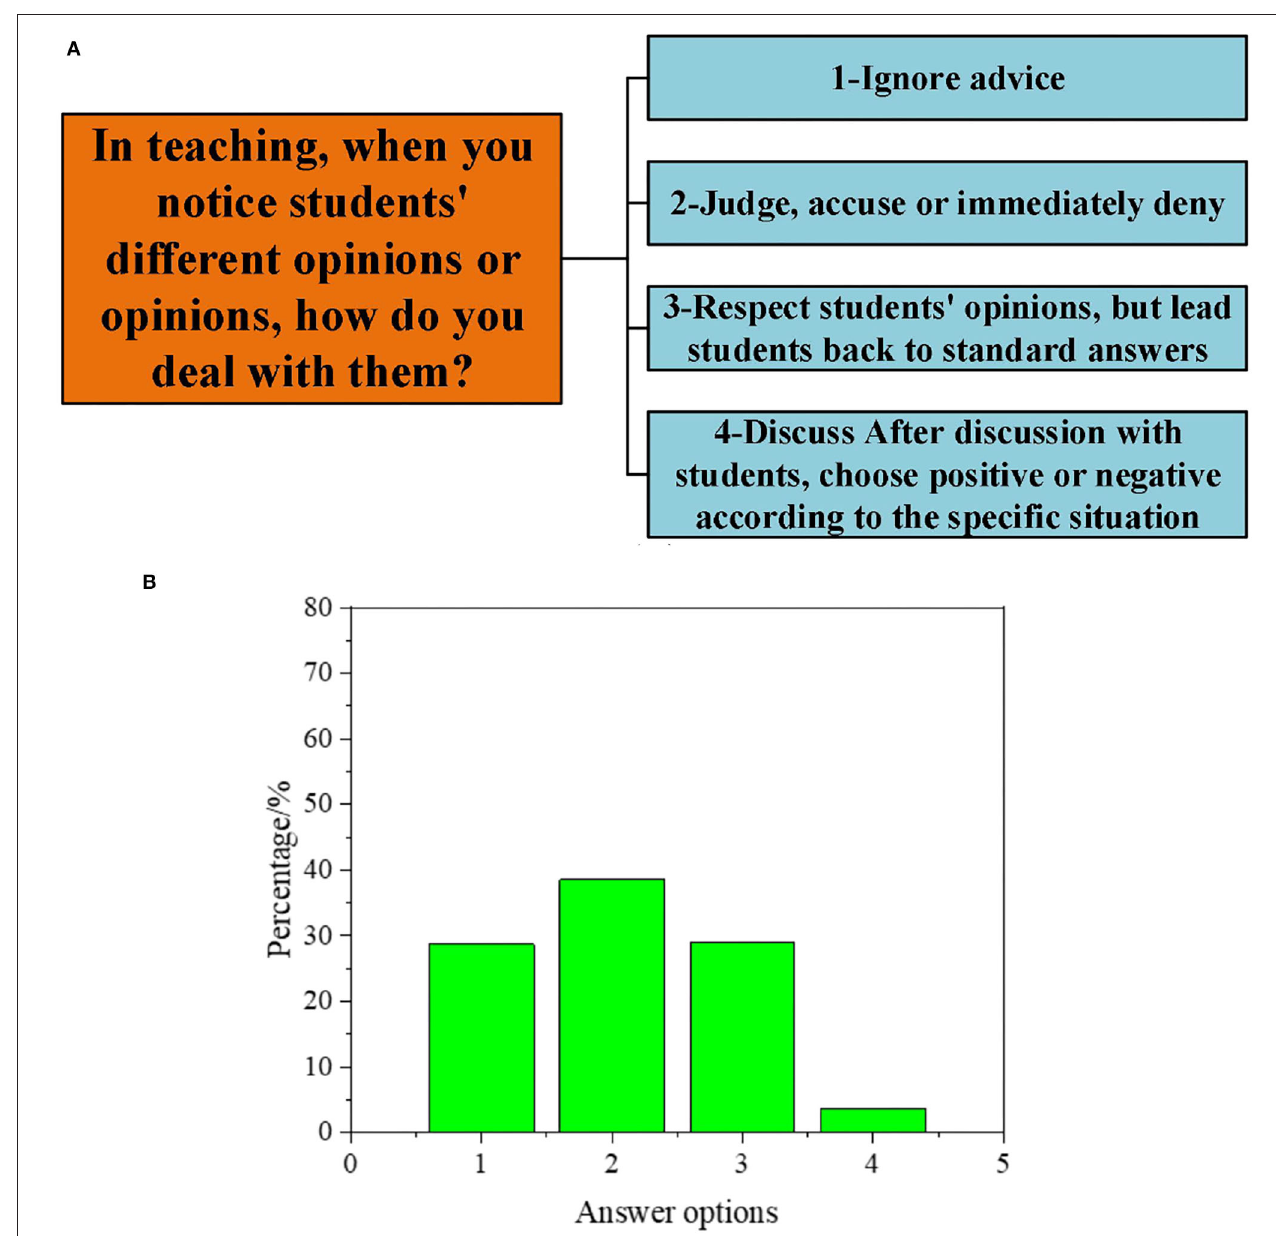
FIGURE 3 | Interview data on the DAU of students’ suggestion-oriented GCR [ (A) : questions and options; (B) : proportion of options].